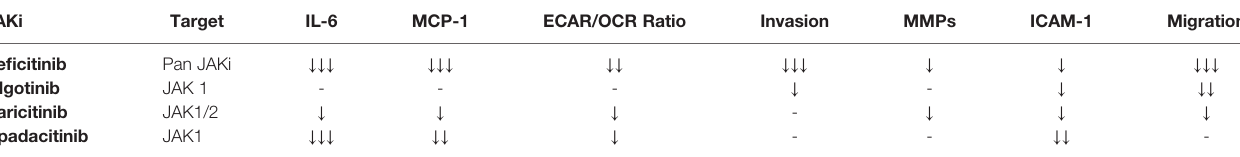
TABLE 2 | Summary of JAKi functions.